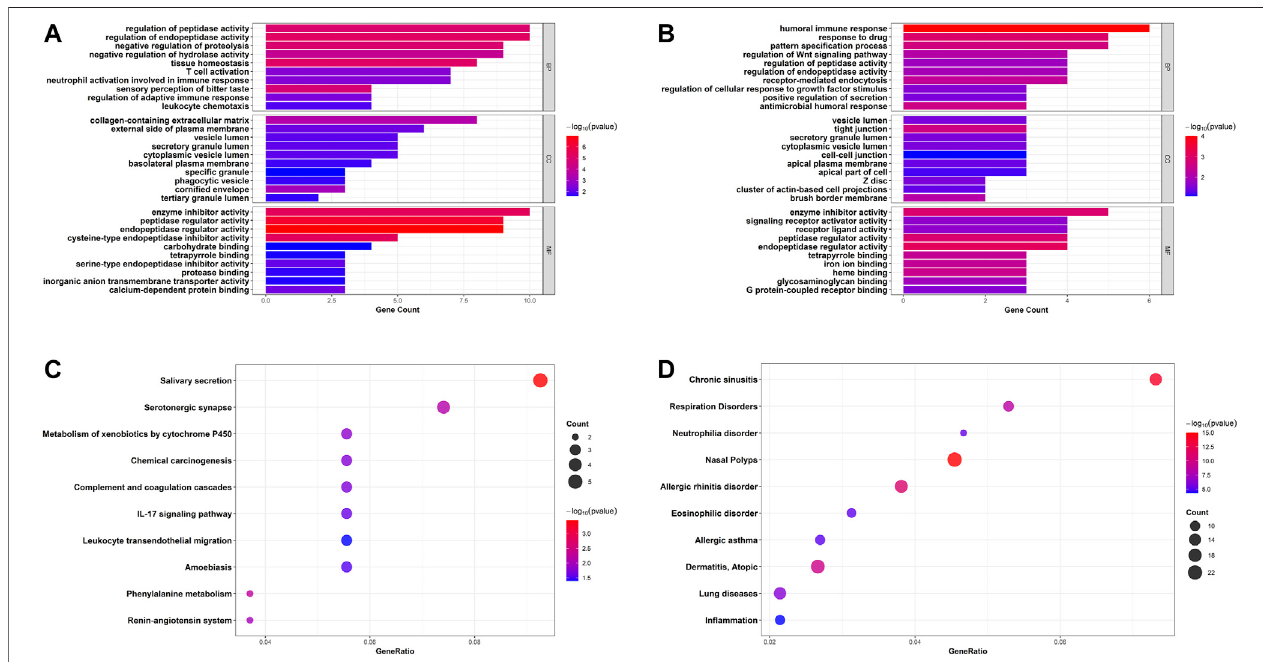
FIGURE 4 | Bar plots and bubble charts of functional annotations involved in asthma. GO enrichment annotations of upregulated DEGs (A) and downregulated DEGs (B) in three categories: BP, CC, and MF; (C) KEGG pathway enrichment analysis of all DEGs; (D) Enrichment analysis of all DEGs in DisGeNET database. GO, Gene Ontology; BP, biological process; CC, cellular component; MF, molecular function; KEGG, the Kyoto Encyclopedia of Genes and